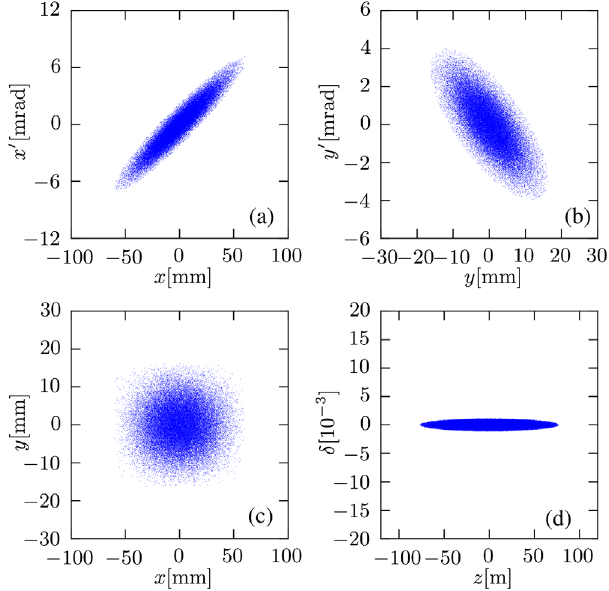
FIG. 2. Particle distribution in (a) x − x 0 phase space; (b) y − y 0 phase space; (c) x − y space and (d) longitudinal z − δ phase space before bunch